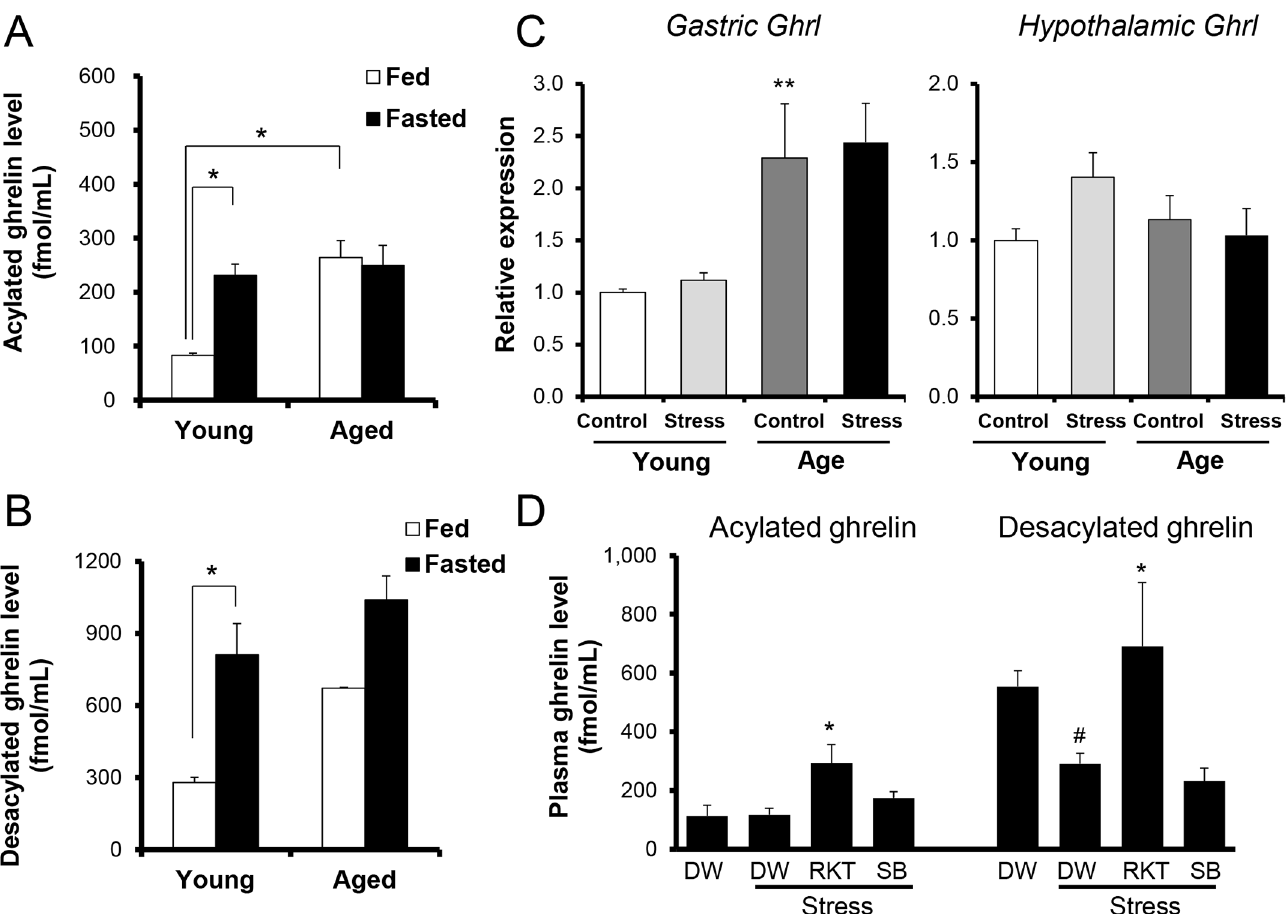
Fig 2. Changes in plasma ghrelin levels and preproghrelin mRNA expression in aged female mice exposed to novelty stress. Changesin the plasma levels of acylatedghrelin(A), desacylatedghrelin(B), gastric (left panel)and hypothalamic (right panel)preproghrelinmRNA expression(C) in the free-fed conditionand the effects of a 5-HT 2C R antagonist and endogenous ghrelinenhancer on plasma ghrelinlevels in aged female mice exposedto novelty stress or not after an 18 h fast (D). The 5-HT 2C R antagonist(SB242084; 6 mg/kg, PO), or ghrelinenhancer (rikkunshito (RKT); 1000 mg/kg, PO) was administered to aged female mice immediately after stress exposure. Data are presented as the mean ± SEM, (A, B) young; fed n = 9, fasted n = 8, aged; fed n = 3, fasted n = 5, (C) young; n = 8, aged; n = 5, (D) n = 5. (A-C); * , p < 0.05, ** , p < 0.01 vs. youngcontrol group, (D); #, p < 0.05 vs. distilledwater (DW)-treated non-stressed group. * , p < 0.05 vs. DW-treated stressed group.